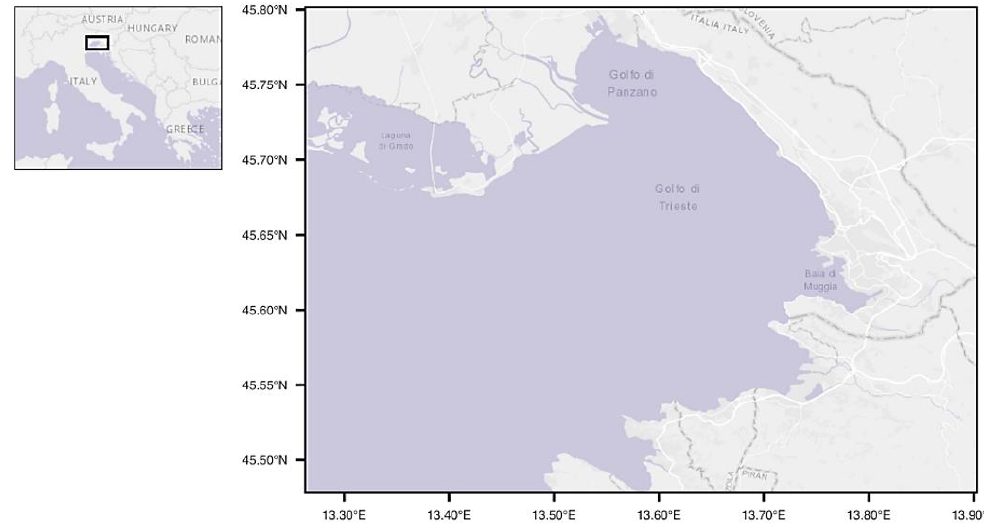
Figure 1. Map of the European sardine sampling area (Gulf of Trieste) and its situation in the Mediterranean Coast.